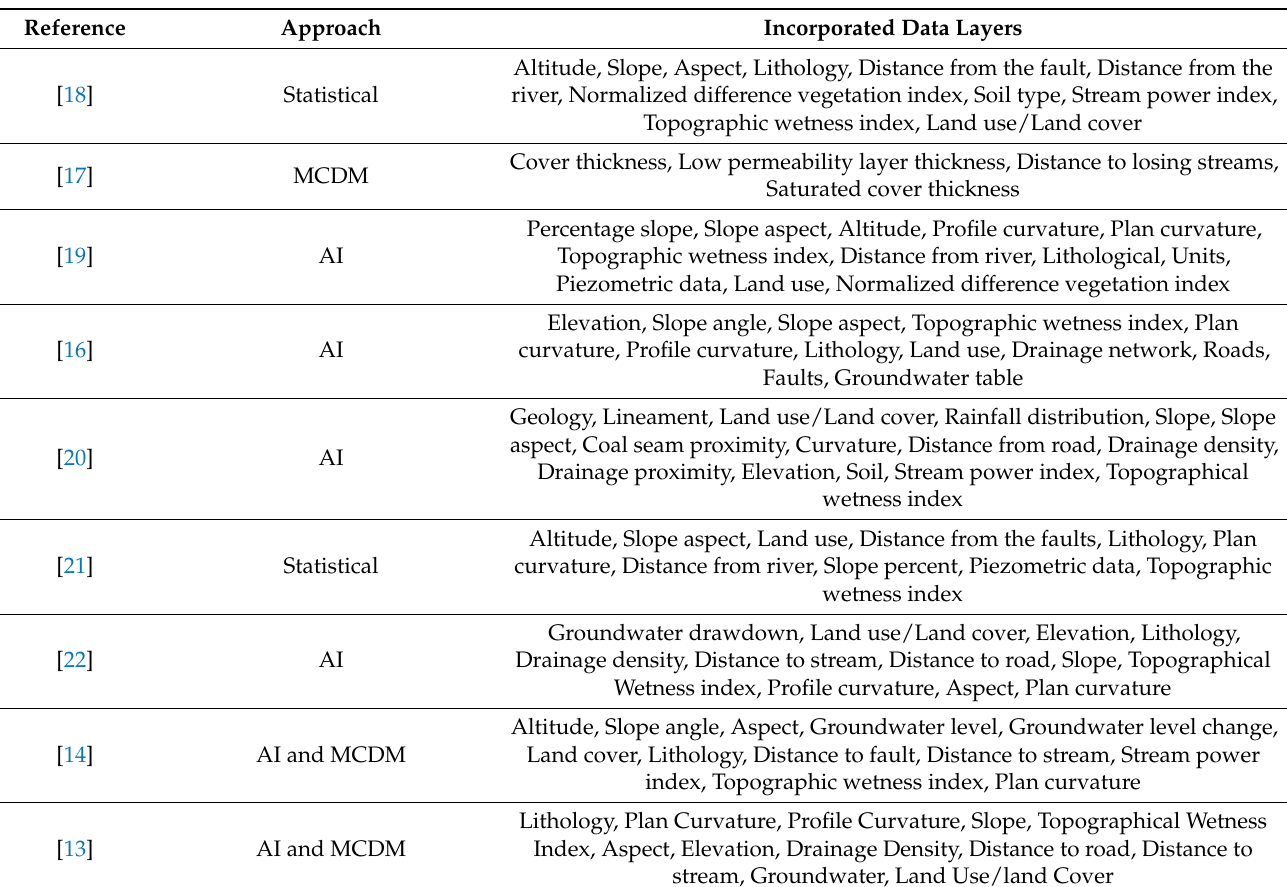
Table 1. Summarized studies to calculate the land susceptibility index or LS hazard